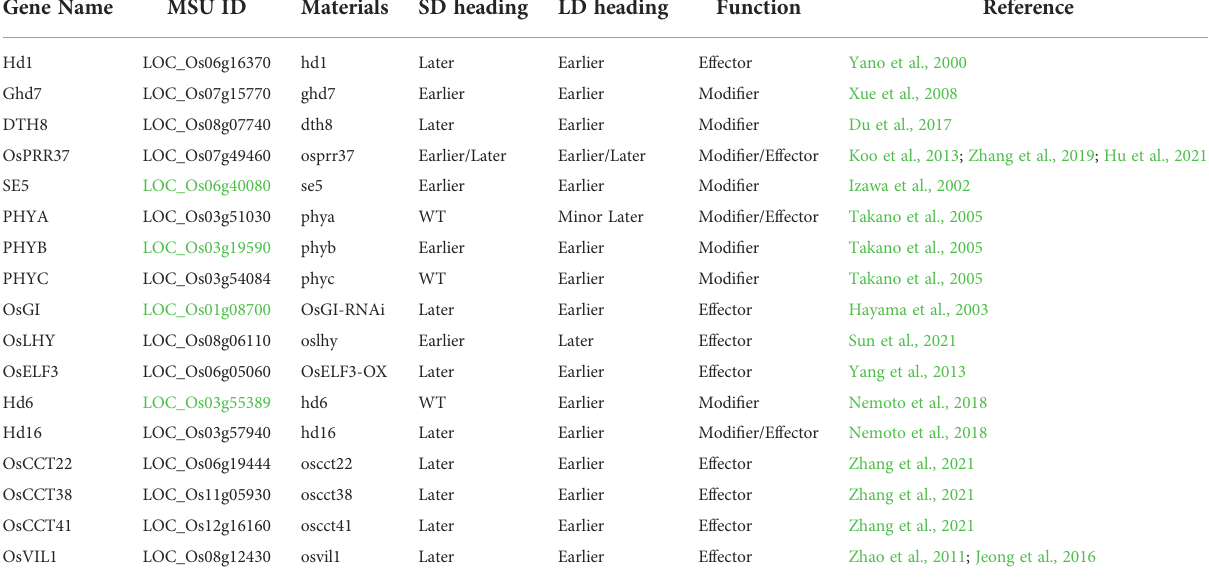
TABLE 1 Regulatory factors of reversal mechanism in rice heading